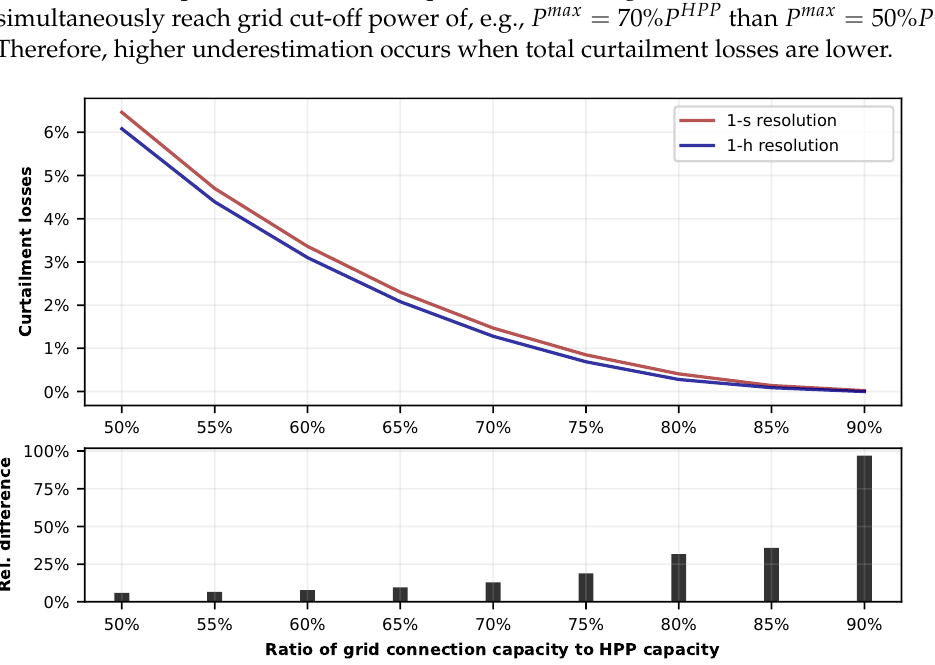
Figure 13. Comparison of curtailment losses captured in 1 s and 1 h resolution for ratio of P max / P HPP in the range 50–90% (5% step) in absolute and relative values for spring months (March, April, May) and 25.6 MW/25.6 MWp installed wind and solar PV